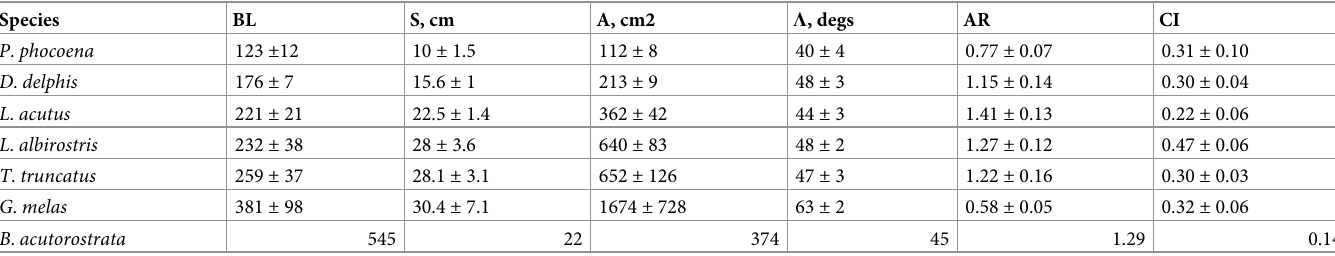
Table 2. Dimensional and dimensionless parameters of the dorsal fins, means ± SD.